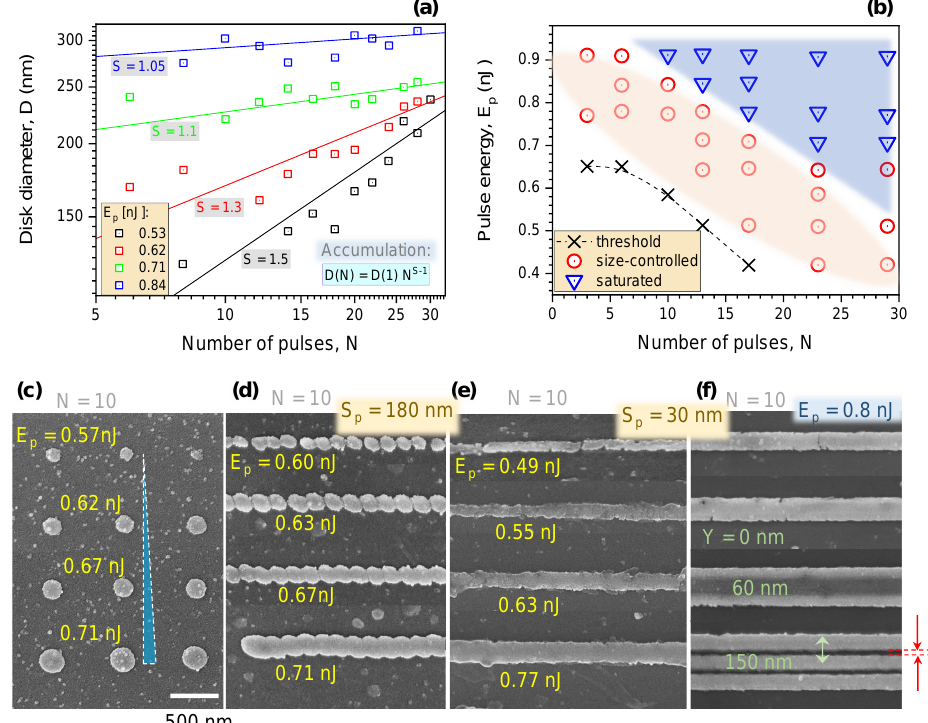
Figure 3. ( a ) Plot showing nano-disk diameter as a function of pulse number N measured by SEM for pulse energies between E p = 0.77 nJ and 0.46 nJ. ( b ) E p vs. N diagram for nano-disk fabrication: threshold of disk formation ( × ), region where different-sized disks can be made ( ◦ ) and where size (diameter) saturates ( (cid:79) ). ( c , d ) c-ITO transitioning from single dots to a line on glass, recorded at different pulse energies E p for N = 10 per irradiation site. ( e ) Formation of lines of different widths by selection of E p , N , and separation S p along the line. ( f ) Pattern of separate lines using vertical Y shift. Polarisation linear (horizontal; along the